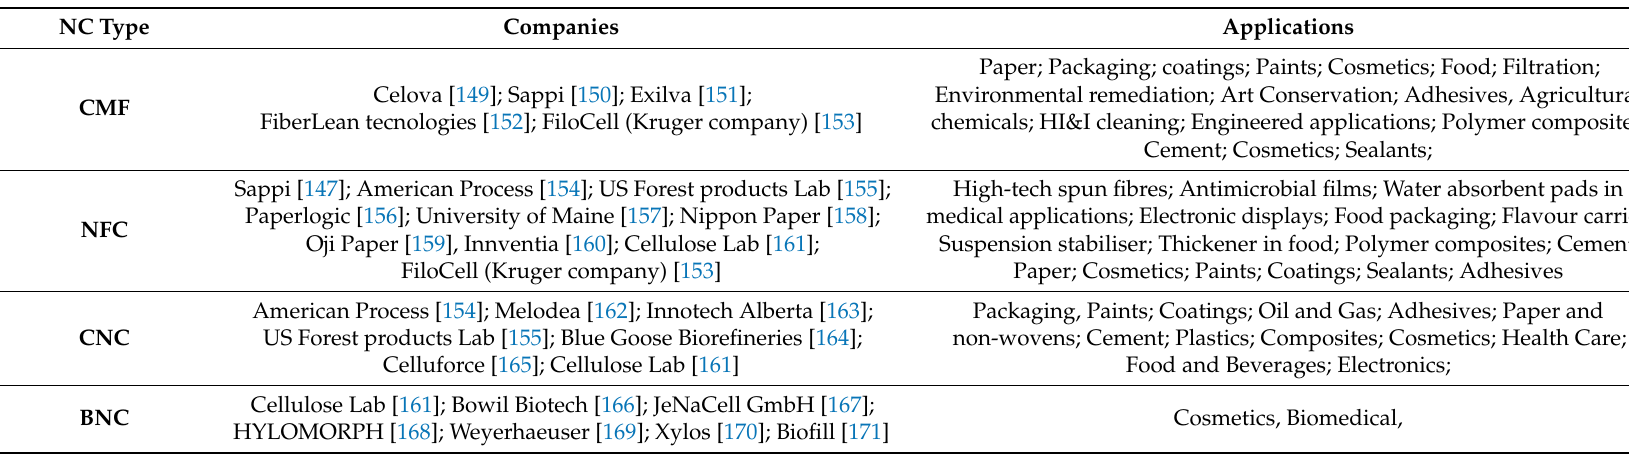
Table 2. Nanocellulose